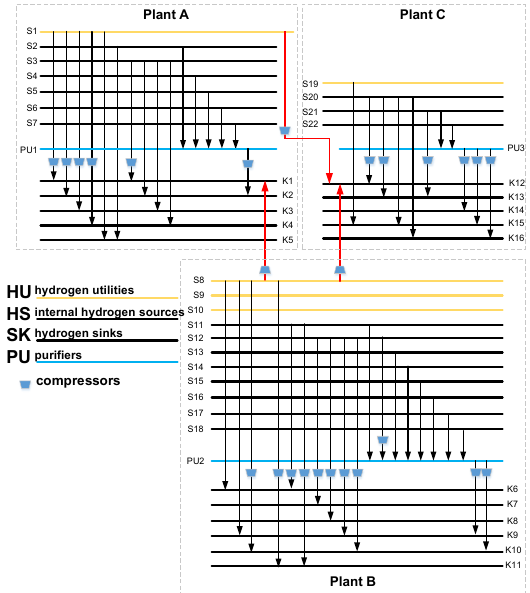
Figure 3. The structure of the inter-plant hydrogen network, obtained by the proposed method.